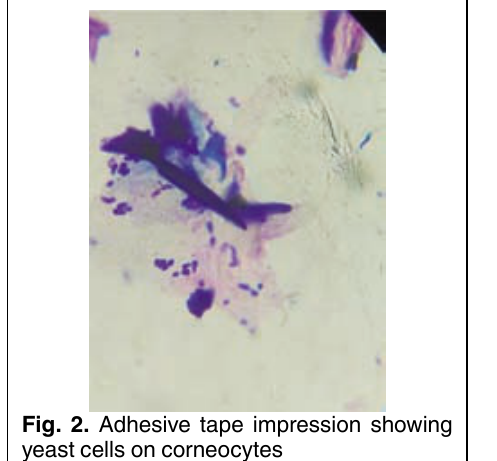
Fig. 1. Malassezia hyperpigmentation